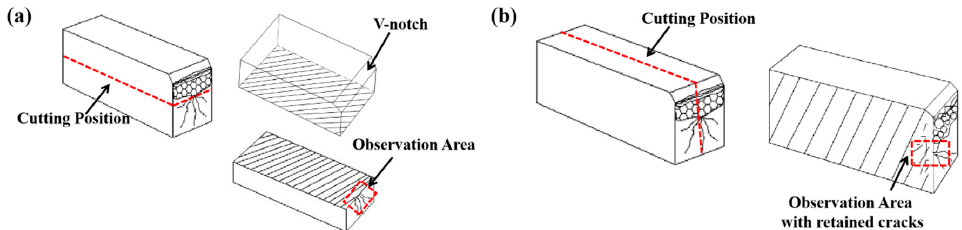
Figure 3. Schematic of metallographic sections from the fractured impact specimens, ( a ) the cutting cross-section parallel to the notch for observation of microstructure nearby fracture initiation, ( b ) the